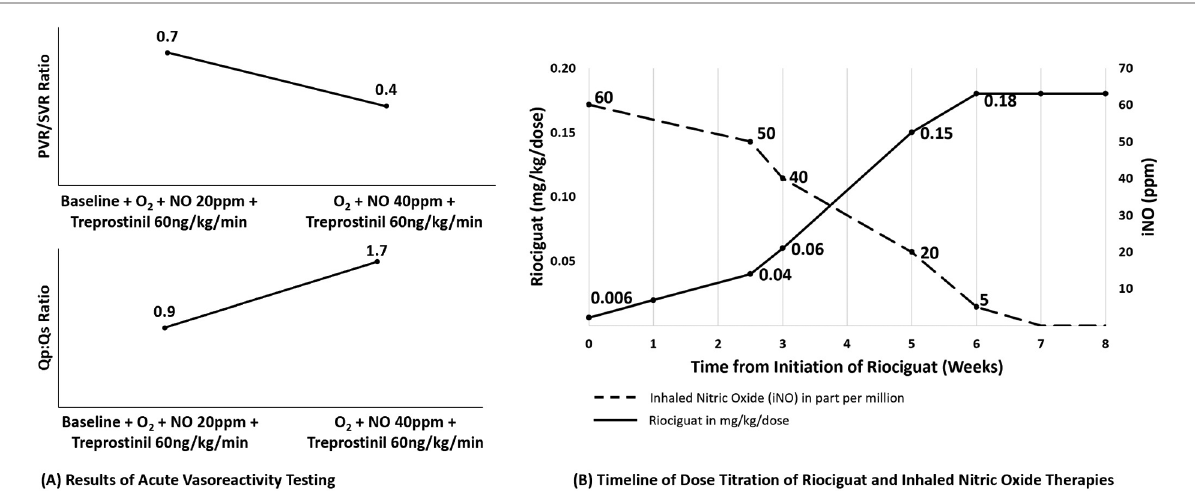
FIGURE 1 Results of acute vasoreactivity testing and timeline of dose titration of riociguat and inhaled nitric oxide therapies for patiennt 1. ( A ) Results of hemodynamic evaluation for patient 1. With acute increase in nitric oxide dose delivery, we observed ( A ) decreased pulmonary vascular resistance and ( B ) increased pulmonary blood fl ow despite background therapy with sildena fi l, treprostinil, high fractional inspired oxygen, and nitric oxide at 20 ppm. ( B ) Timeline for initiation of riociguat therapy and weaning off inhaled nitric oxide. Riociguat therapy was started at very low dose (0.006 mg/kg/dose=0.05 mg total dose once per day) and uptitrated slowly over 7 weeks to a dose of 2 mg/dose TID while nitric oxide was weaned over a similar timeframe. Not shown, over the subsequent 6 months his dose was titrated up to fi nal dose of 2.5 mg TID. O 2 , oxygen; NO, inhaled nitric oxide; PVR, pulmonary vascular resistance; SVR, systemic vascular resistance; Qp, pulmonary fl ow; Qs, systemic fl ow.